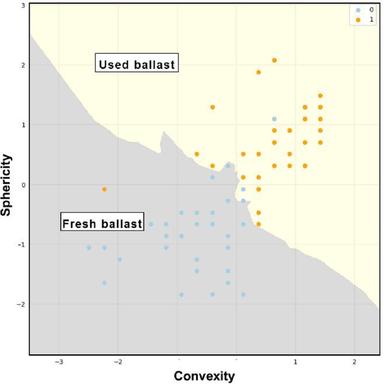
KNN result between the fresh and used ballast classification.